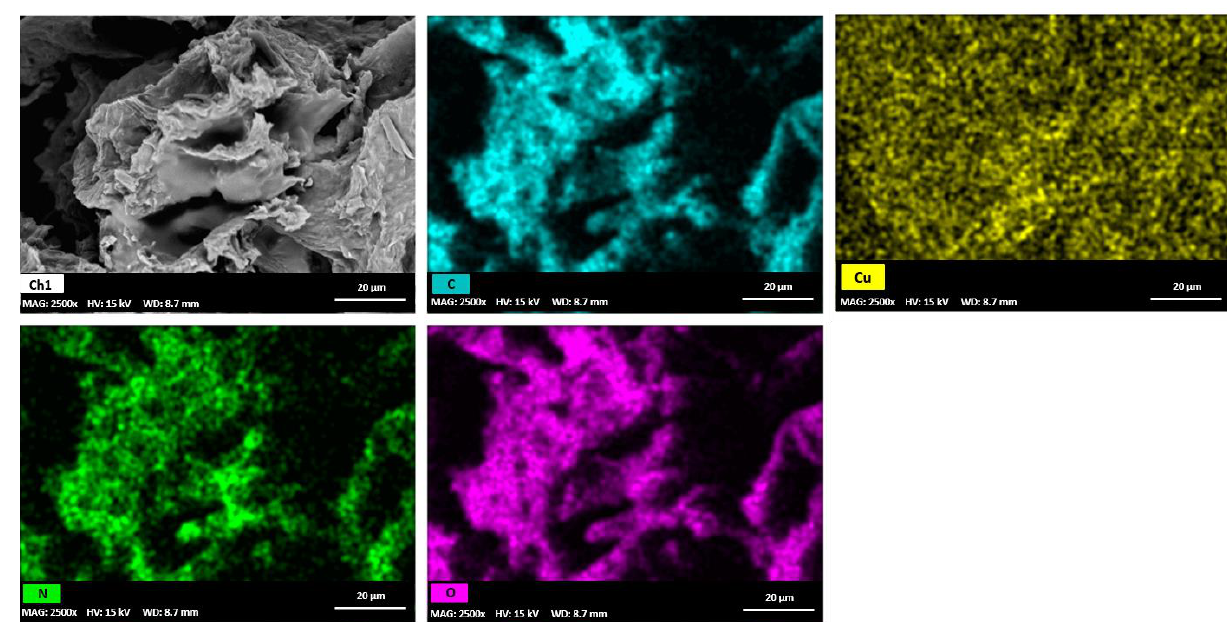
Figure 1. Distribution of elements on CNS-Zn observed with EDS analysis.